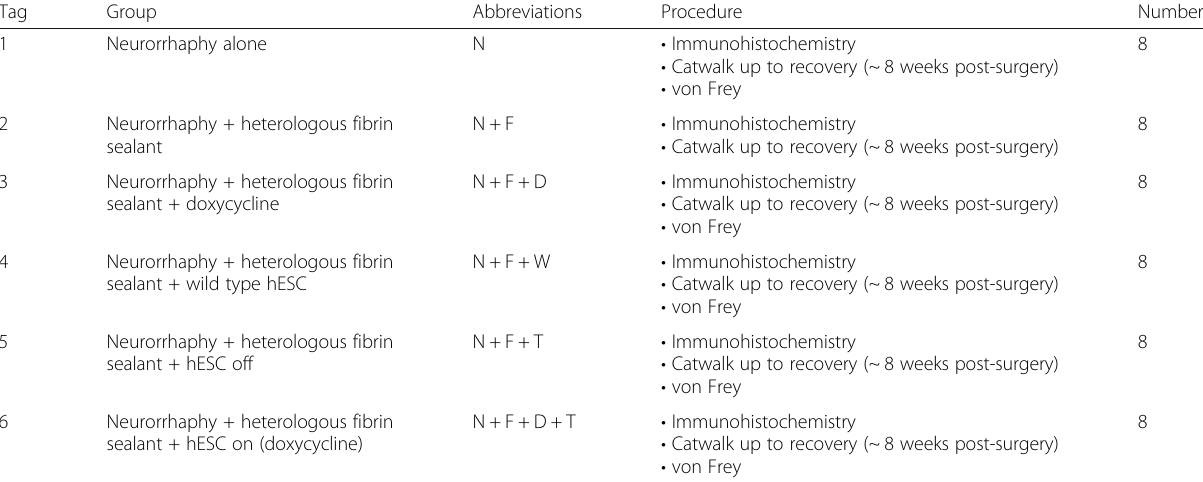
Table 1 Experimental groups and experimental